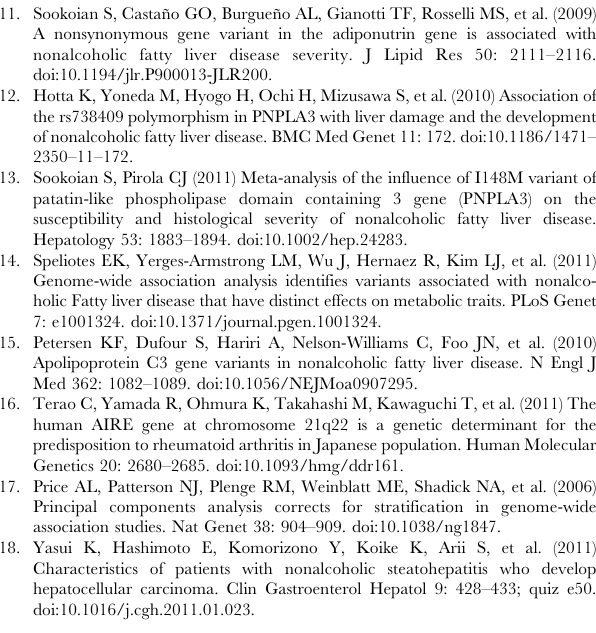
{ P -values are calculated by Jonckheere-Terpstra test in NAFLD patients for Matteoni type and additive model of genotype. SNPs are ordered by chromosomal location.